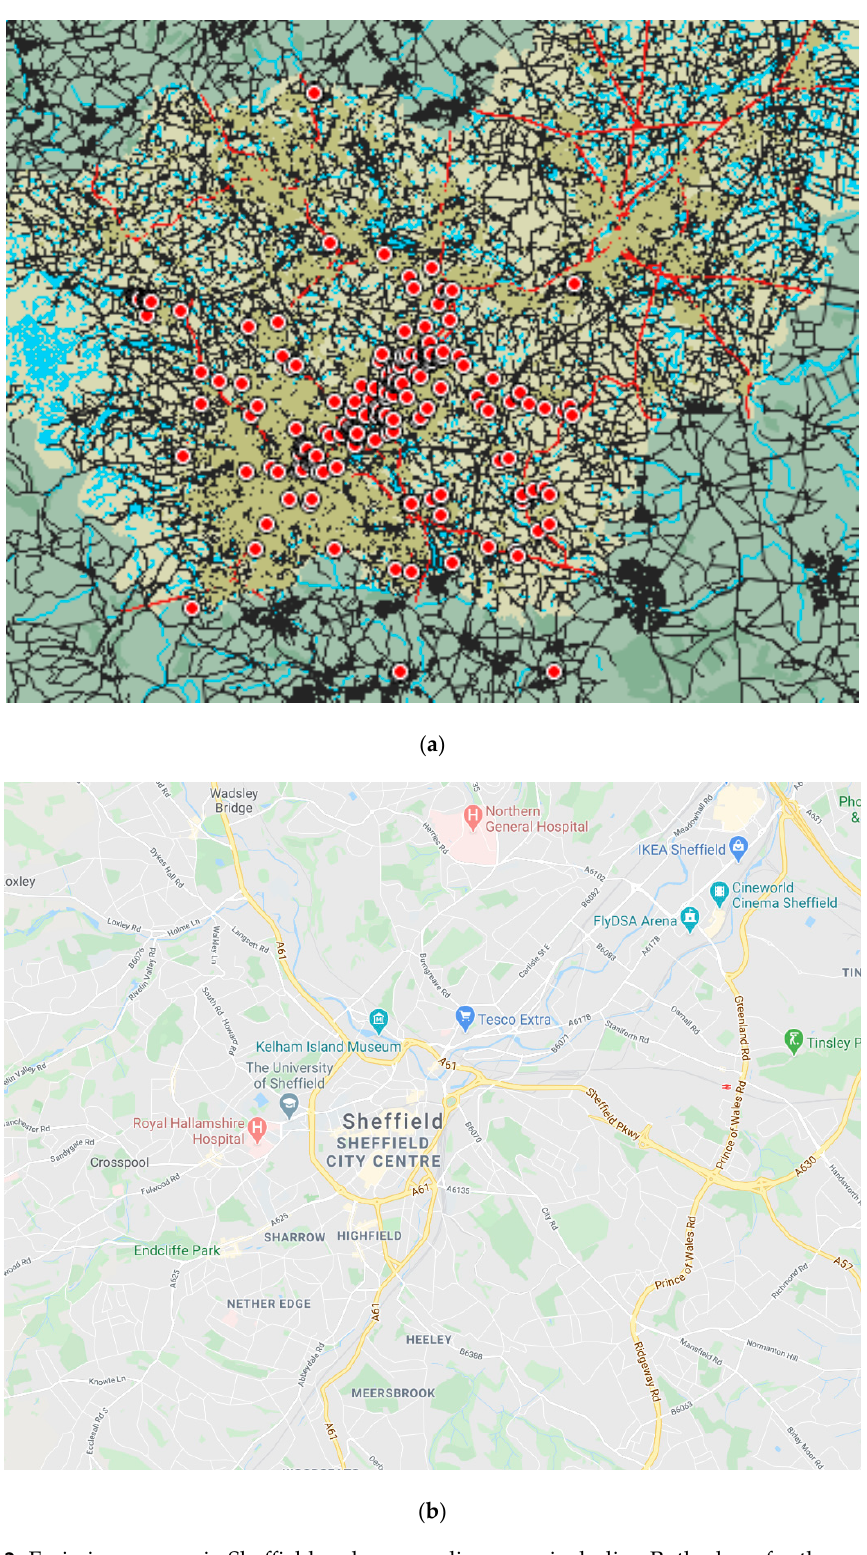
Figure 2. Emission sources in Sheffield and surrounding areas including Rotherham for the year 2017: ( a ) point sources, ( b ) road network or line sources.